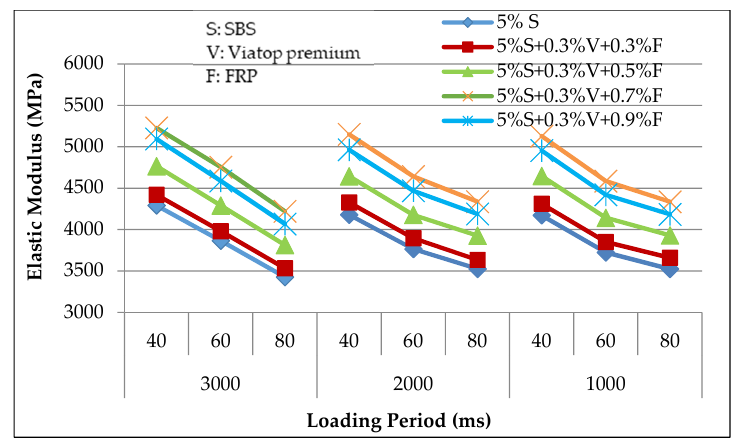
Figure 7. Resilient modulus test results, 5 °C.